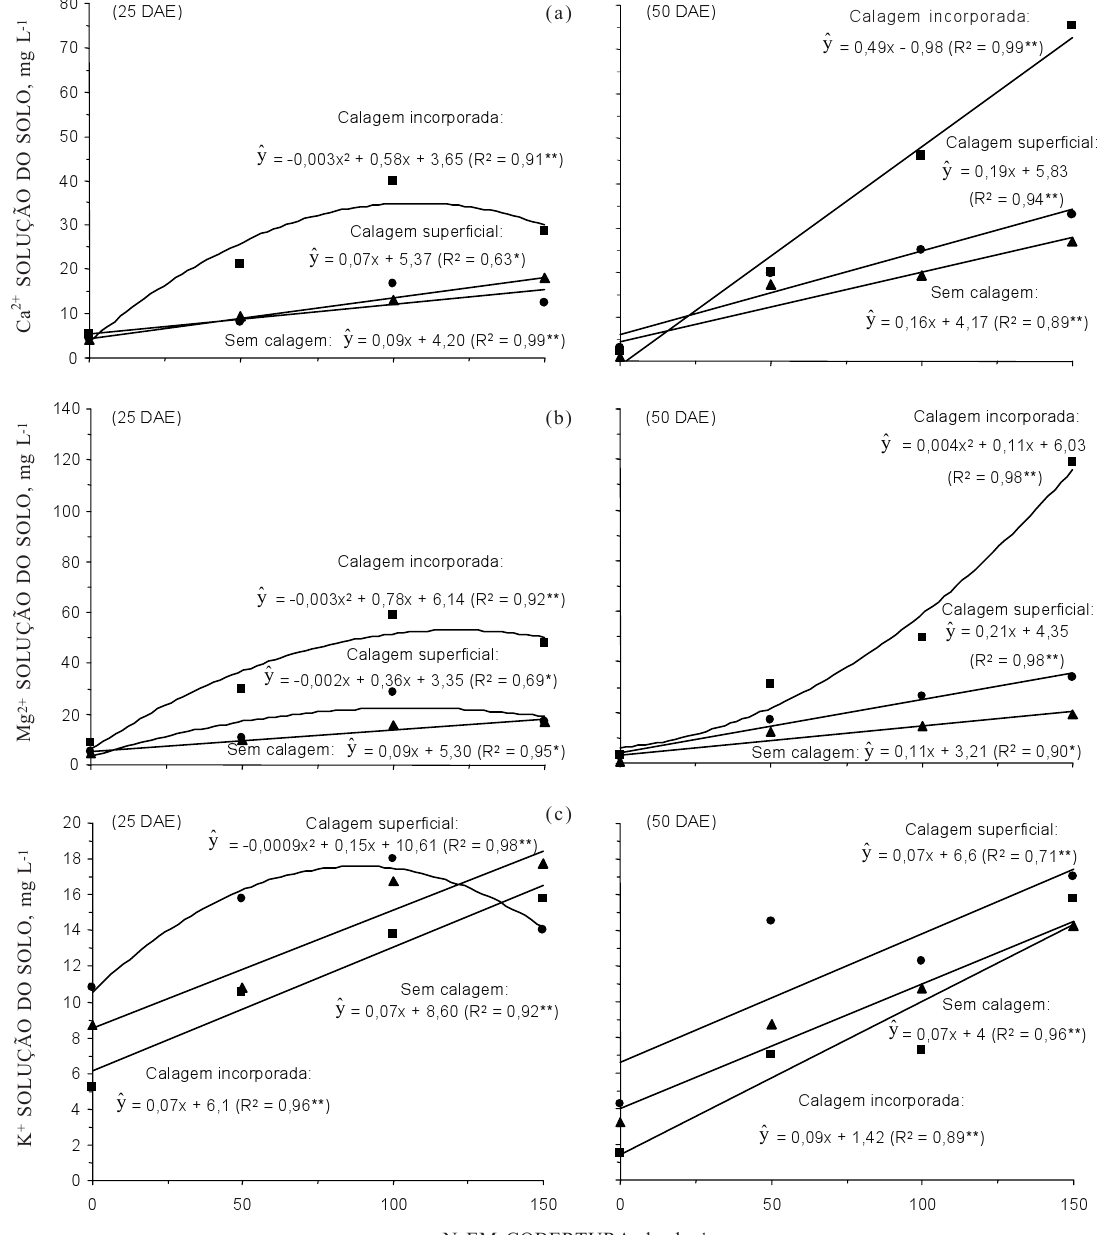
Figura 2. Concentrações de cálcio (a), magnésio (b) e potássio (c) da solução do solo, em função das doses de N aplicadas em cobertura, nas condições de calagem superficial ( ), calagem incorporada ( ) e sem calagem ( ), aos 25 e 50 DAE do algodão. * e ** significativos a 5 e 1 %, respectivamente. ns: não-